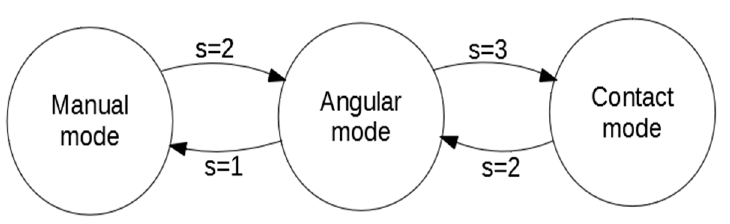
Figure 7. Mode switching.